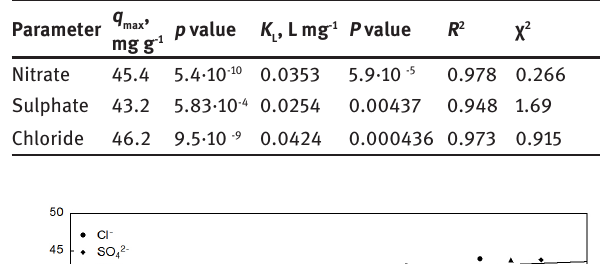
1.0 g L -1 , C – 25-300 mg L -1 , S 0